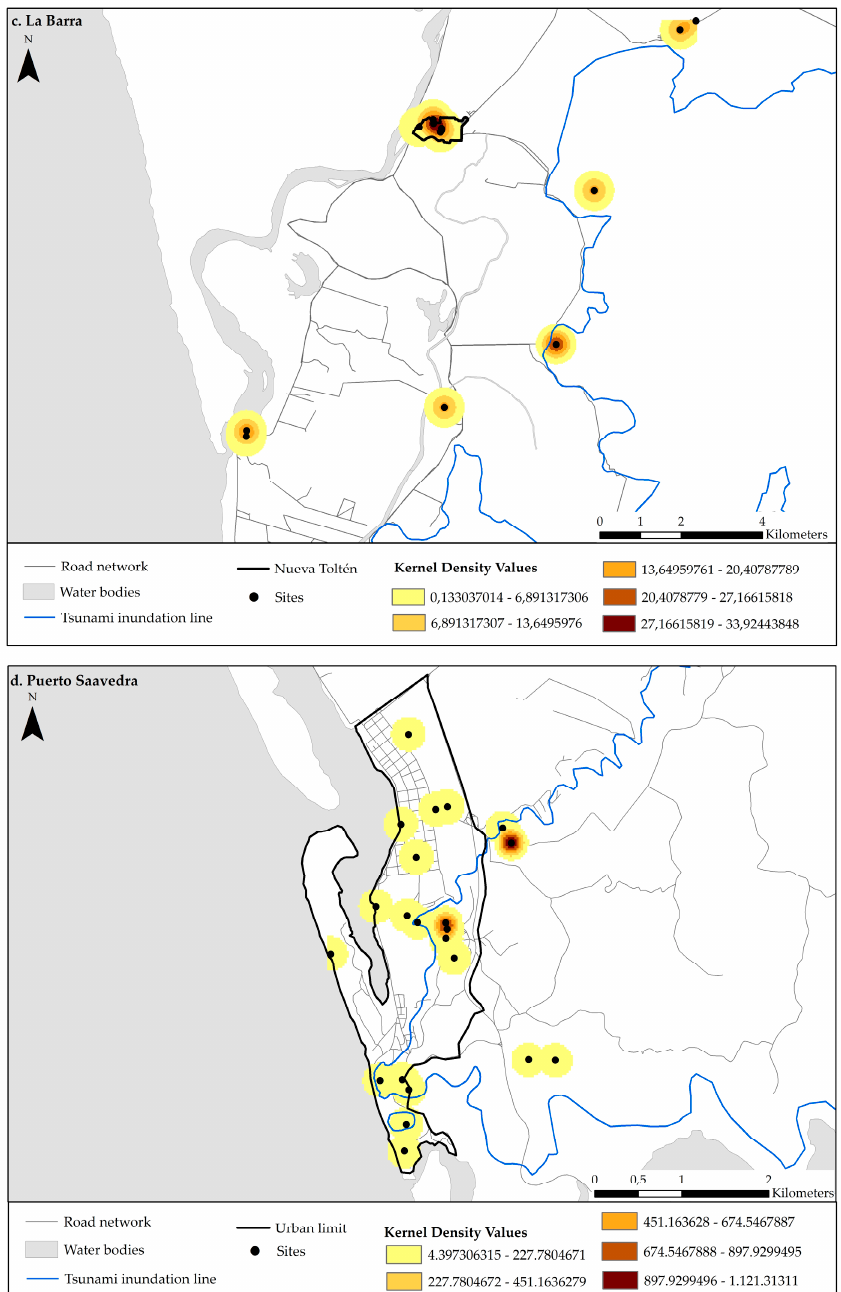
Figure 6. ( a ) Kernel Density Map: Mehuín; ( b ) Kernel Density Map: Queule; ( c ) Kernel Density Map: La Barra; ( d ) Kernel Density Map: Puerto Saavedra.